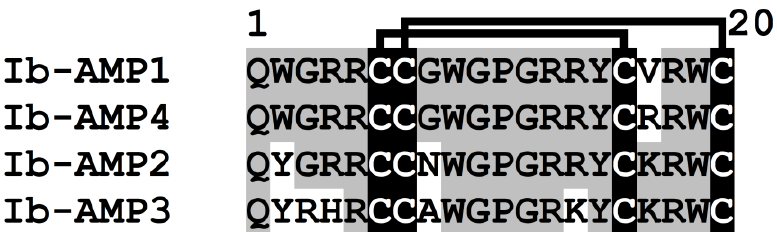
Figure 7. Multiple sequence alignment of the antimicrobial peptides Ib-AMPs from Impatiens balsamina [9]. Cysteine residues are highlighted in white on the black background. Conserved amino acid residues are highlighted in black on the grey background. Lines above the sequences denote disulfide bonds.